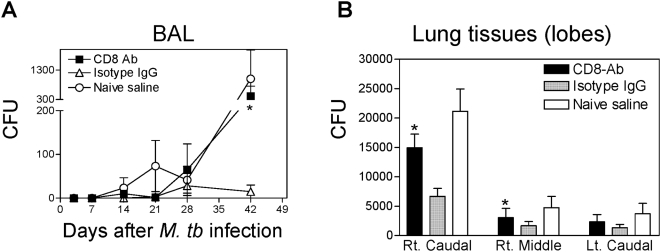
Depletion of CD8 lymphocytes resulted in a significant decrease in BCG-induced immune control of M. tuberculosis.(A) CD8 Ab-treated macaques exhibited higher levels of bacilli in BAL fluid than isotype IgG-treated macaques after pulmonary M. tuberculosis infection. Data are means +/− SEM of CFU counts/10 ml BAL fluid derived from 6 macaques for each group; * indicates p<0.05 for a comparison between the CD8 Ab-treated and isotype IgG-treated group. (B) CD8 Ab-treated macaques showed significantly higher levels of bacilli organisms in lung tissues than isotype control macaques after pulmonary M. tuberculosis infection. Data are mean values with SEM error bars of CFU counts/1 ml lung tissue homogenates derived from 6 macaques for each group. Rt, right; Lt, left. Note that right caudal lobe was the M. tuberculosis infection site for each macaque; *, p<0.05 (by both ANOVA and nonparametric t test) for a comparison between the CD8 Ab-treated and isotype control IgG-treated groups.